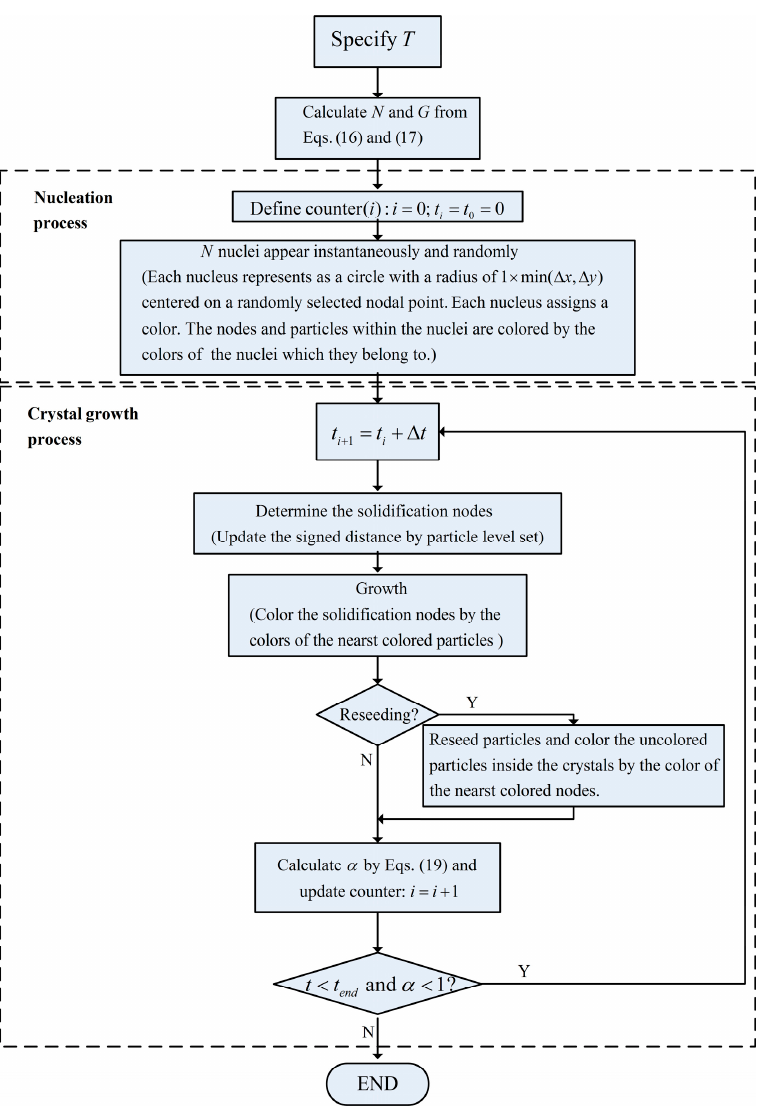
Figure 4. Algorithm for polymer crystallization under isothermal conditions using the particle level set method.